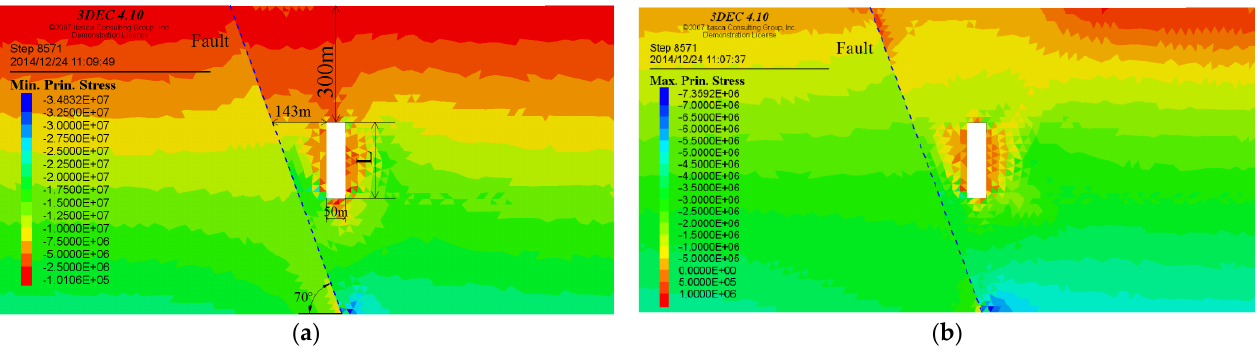
Figure 18. The stress field distribution in the surrounding rock at the excavation size of 50 m × 200 m, they should be listed as: ( a ) Maximum principal stress distribution; ( b ) Minimum principal stress distribution.